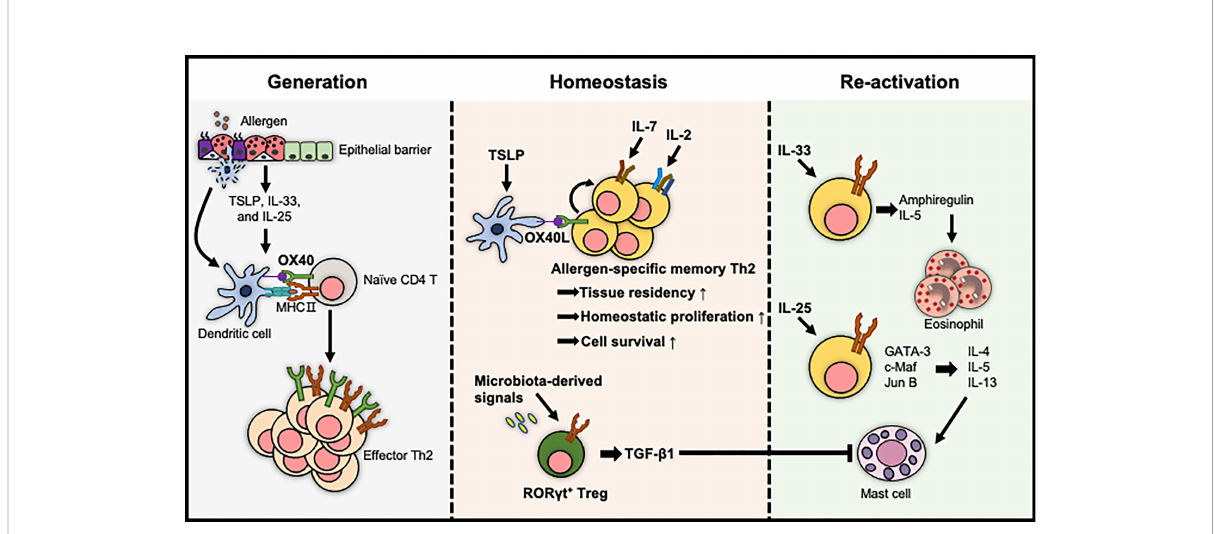
FIGURE 2 The extrinsic factors for the regulation of allergen-speci fi c memory CD4 T cells. The generation of effector Th2 cells is proposed to be enhanced by the tissue-derived cytokine/DC axis. The pool of allergen-speci fi c memory Th2 cells and their tissue residency are maintained either by cytokines such as IL-2 and IL-7 or by OX40L expressed on TSLP-activated DCs. In contrast, TGF- b 1 produced by ROR g t + Tregs, which are differentiated by microbiota-derived signals, induces immune tolerance. The reactivation of allergen-speci fi c memory Th2 cells is mediated by IL-33 and IL-25, exacerbating allergic diseases in an allergen-independent